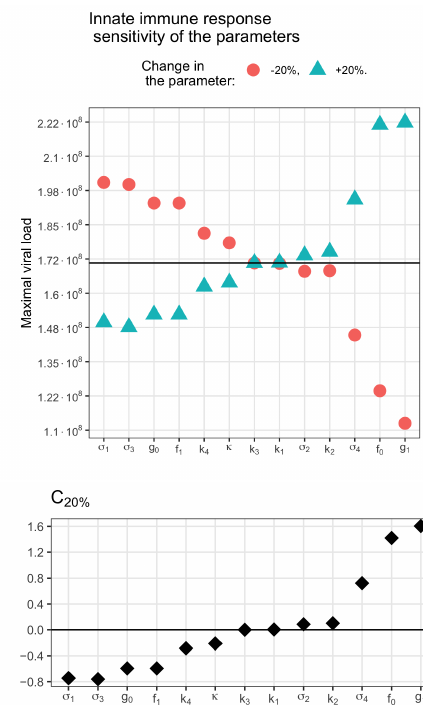
Figure 14. Numerical evaluations of antibody production depending on the vaccine dose ( V ac initial). Left : maximal antibody concentration on 30th, 120th and 180th days after vaccination. Right : time to reach the maximal concentration of antibodies depending on vaccine dose.